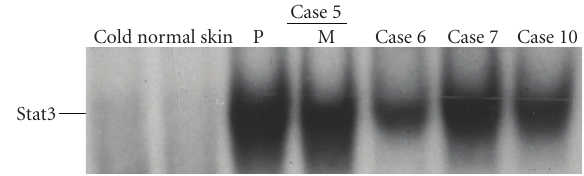
Figure 2: Analysis of Stat3 activation in human cutaneous SCC tissues. Nuclear extracts were generated from surgical tissues. In case 5, normal skin, primary lesion (P), and metastatic lesion (M) of SCC from the same patient were analyzed for Stat3 activation using EMSA with a 32 P-labeled DNA probe to detect binding activity of Stat3. Specificity of the DNA-binding complex was evaluated by competition with excess unlabeled Stat3 oligonucleotide (cold). Stat3 activation of the primary lesions of the other 3 cases was also analyzed. Three of the 4 primary lesions and a metastatic SCC showed the strong DNA binding activity of Stat3 while little activation was seen in normal skin samples examined and in one primary SCC lesion (case 6). Data of normal skin are representative of 4 normal skin